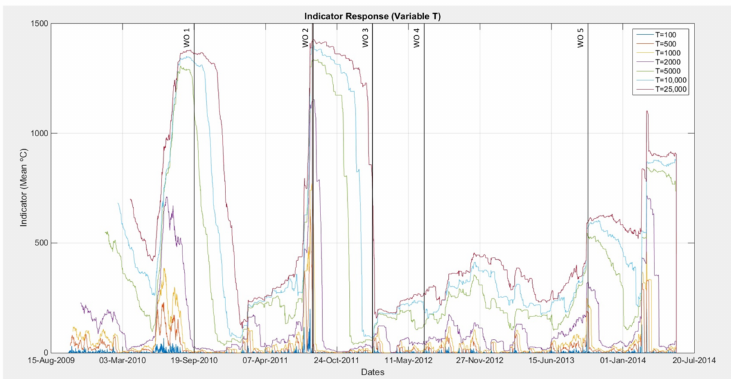
Figure 12. Results of the indicator varying the period of calculation of the moving mean ( T ).